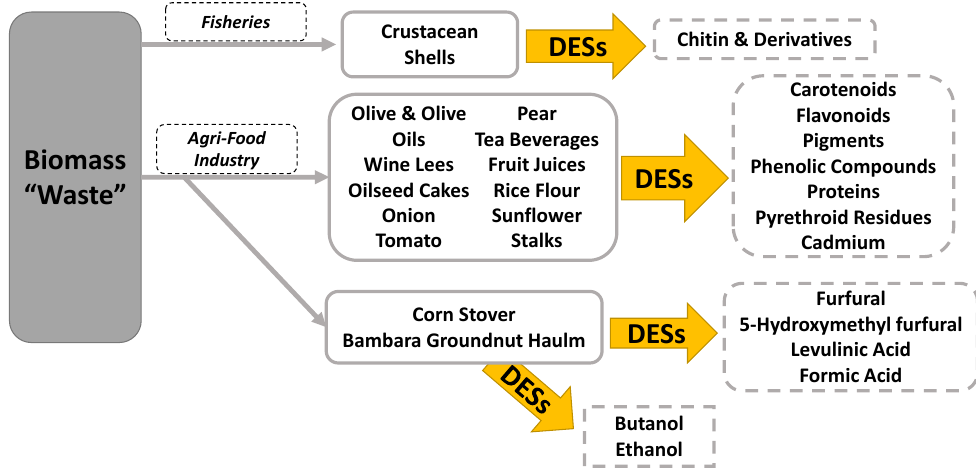
Figure 1. Overview of the examples of biomass-based waste treated with DESs for its valorization discussed in this review.